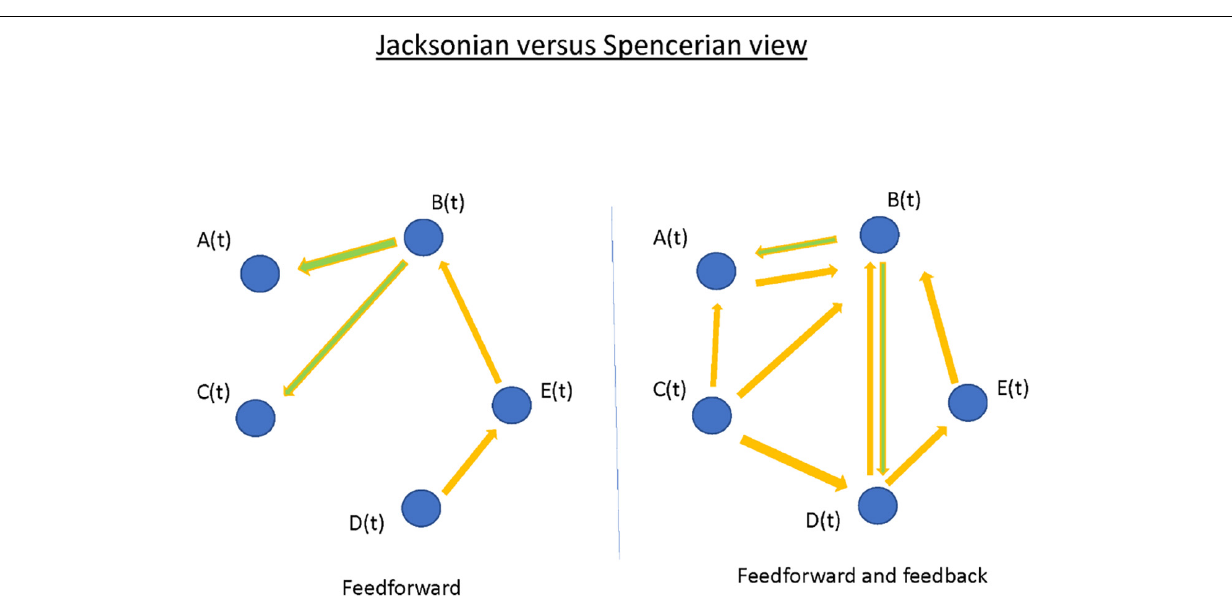
FIGURE 9 | Network propagation models of partial epilepsy